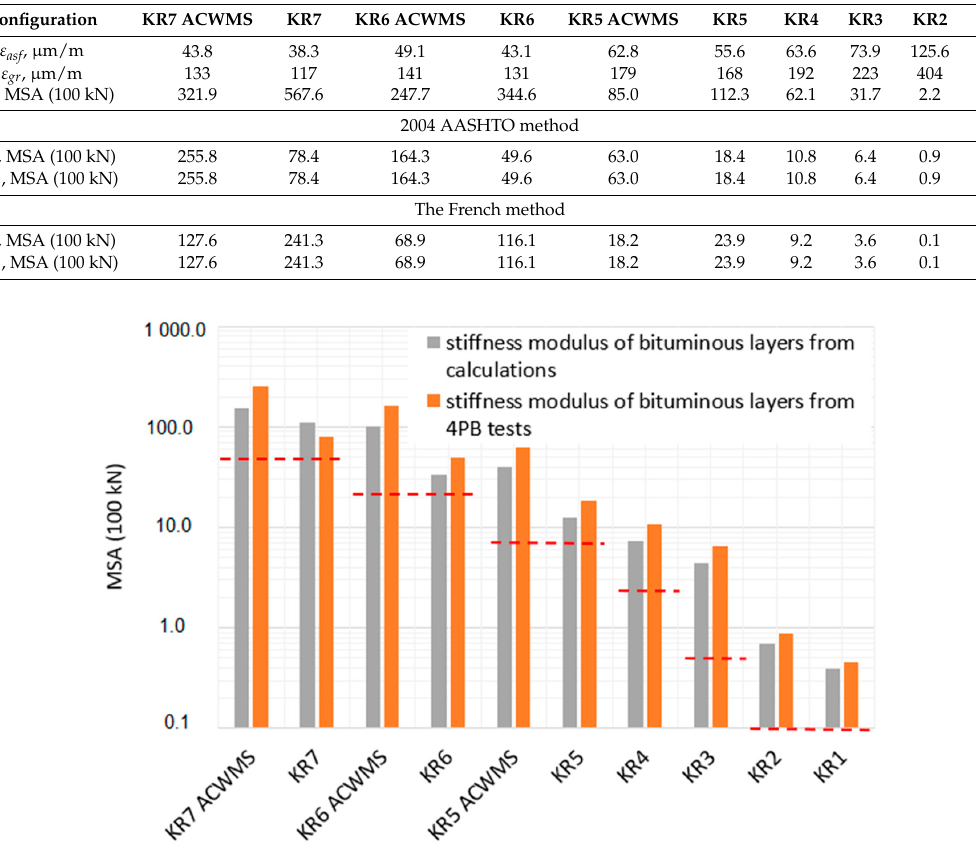
Figure 8. Results of calculations of pavement structure durability according to the 2004 AASHTO criterion.